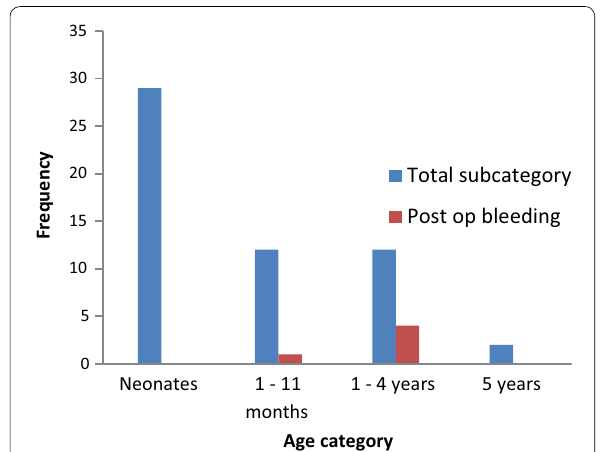
Fig. 2 Postoperative bleeding in boys that had Plastibell